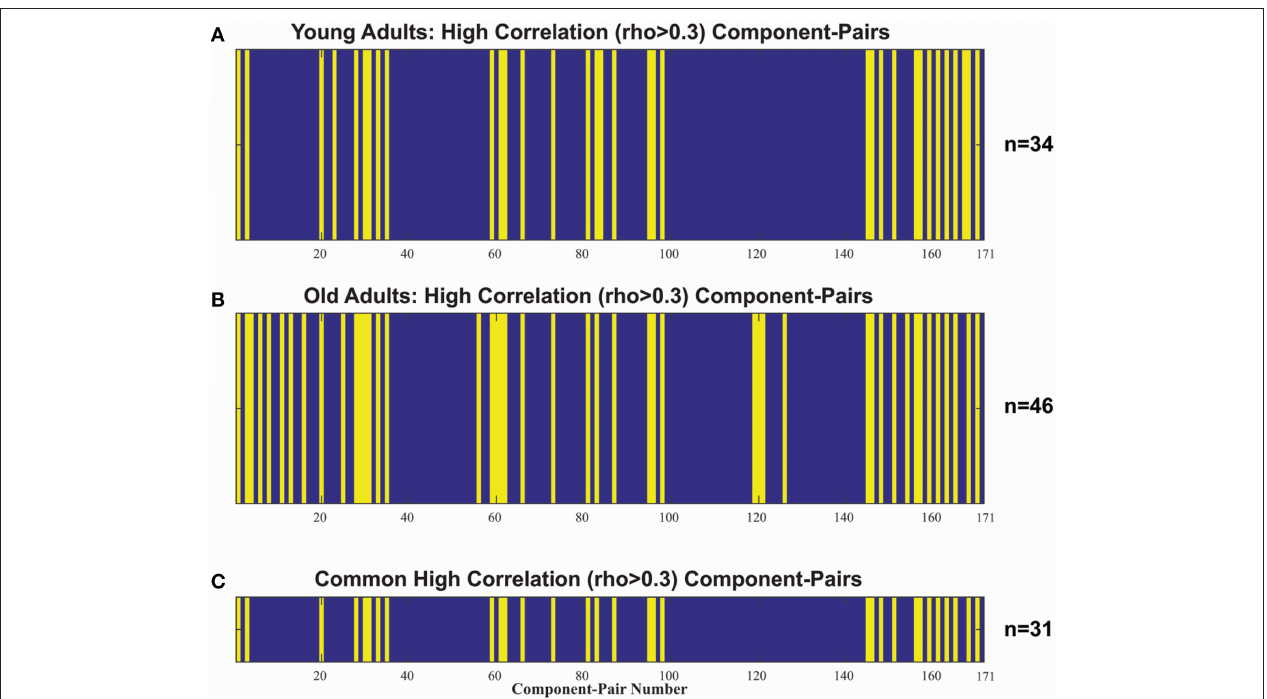
FIGURE 3 | Indexes of the 171 unique comp-pair transpose into a 1-dimension vector, detailing non-noise component-pairs with high correlations in (A) the young adult (18–30 y.o) group ( n = 34 ), and (B) the older ( > 50 y.o.) adult group ( n = 46 ). Blue denotes rho ≤ 0.3 and Yellow denotes rho > 0.3. (C) illustrates the 31 high-correlation component-pairs overlap between the two populations, which was used to compare the age-related inter-network correlation differences.